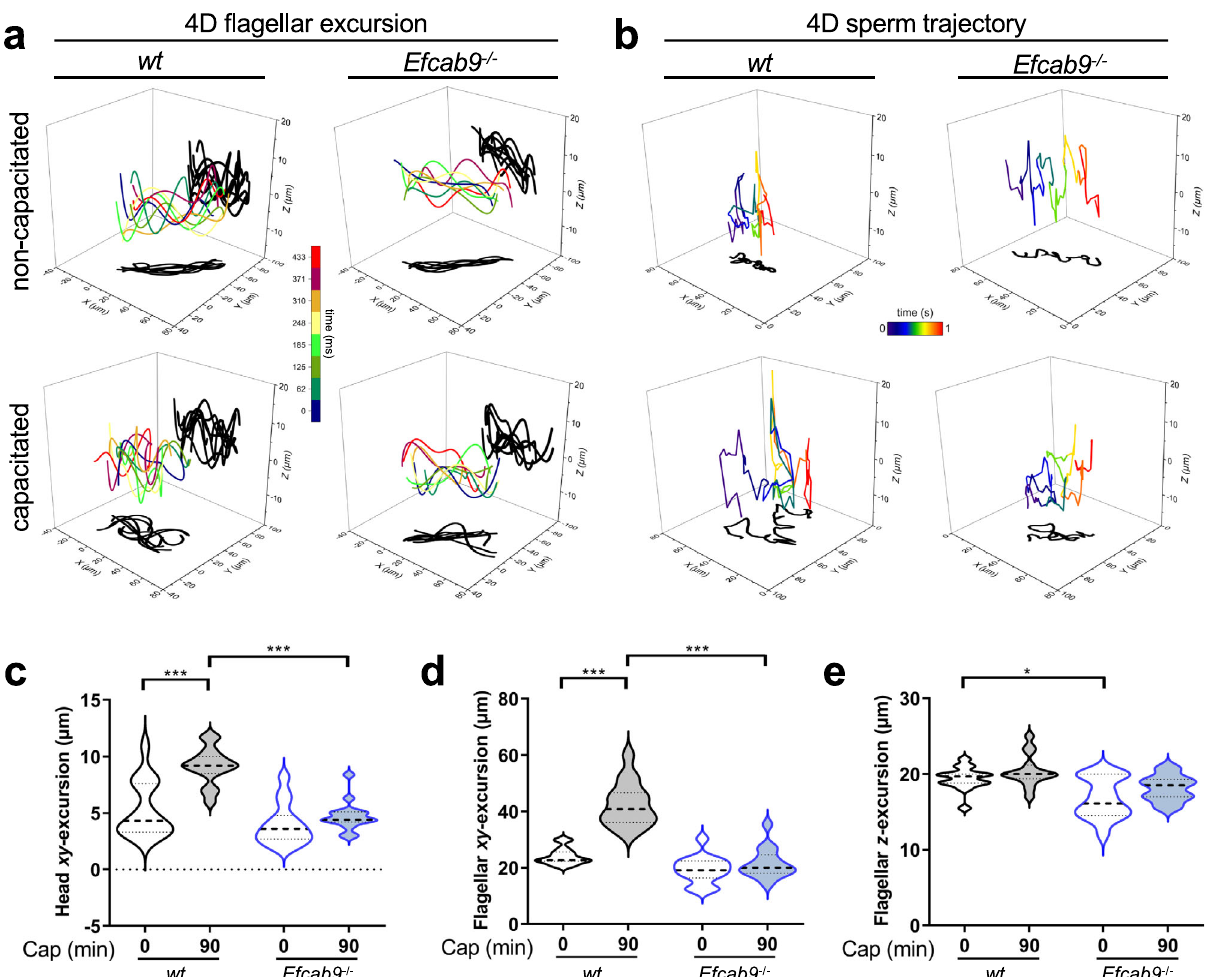
Fig. 6 Flagellar beating waveform of free-swimming sperm in four dimensions. a 4D fl agellar beating waveform analyses of wild type and Efcab9 − / − sperm by high-speed digital holographic microscopy (DHM). The time-lapse trace of a fl agellum at 3D position (laboratory- fi xed frame of reference xyz ) is visualized in color and its projections onto xy - and xz -planes are shadowed in black. b 4D sperm trajectory analyses of wild type and Efcab9 − / − sperm by DHM. The swimming trajectory of sperm is visualized by tracing the head position. c – e Statistical analyses of head ( c ) and fl agellar ( d ) xy -excursion, and fl agellar z -excursion ( e ) from ( a ). n = 15 per group of three animals, a two-way repeated-measures ANOVA statistical test was performed, * p (0.0177)< 0.05, *** p <0.001, p value below 0.001 cannot be given as exact value; the medians (thick dash lines) and interquartile ranges (thin dash lines) are